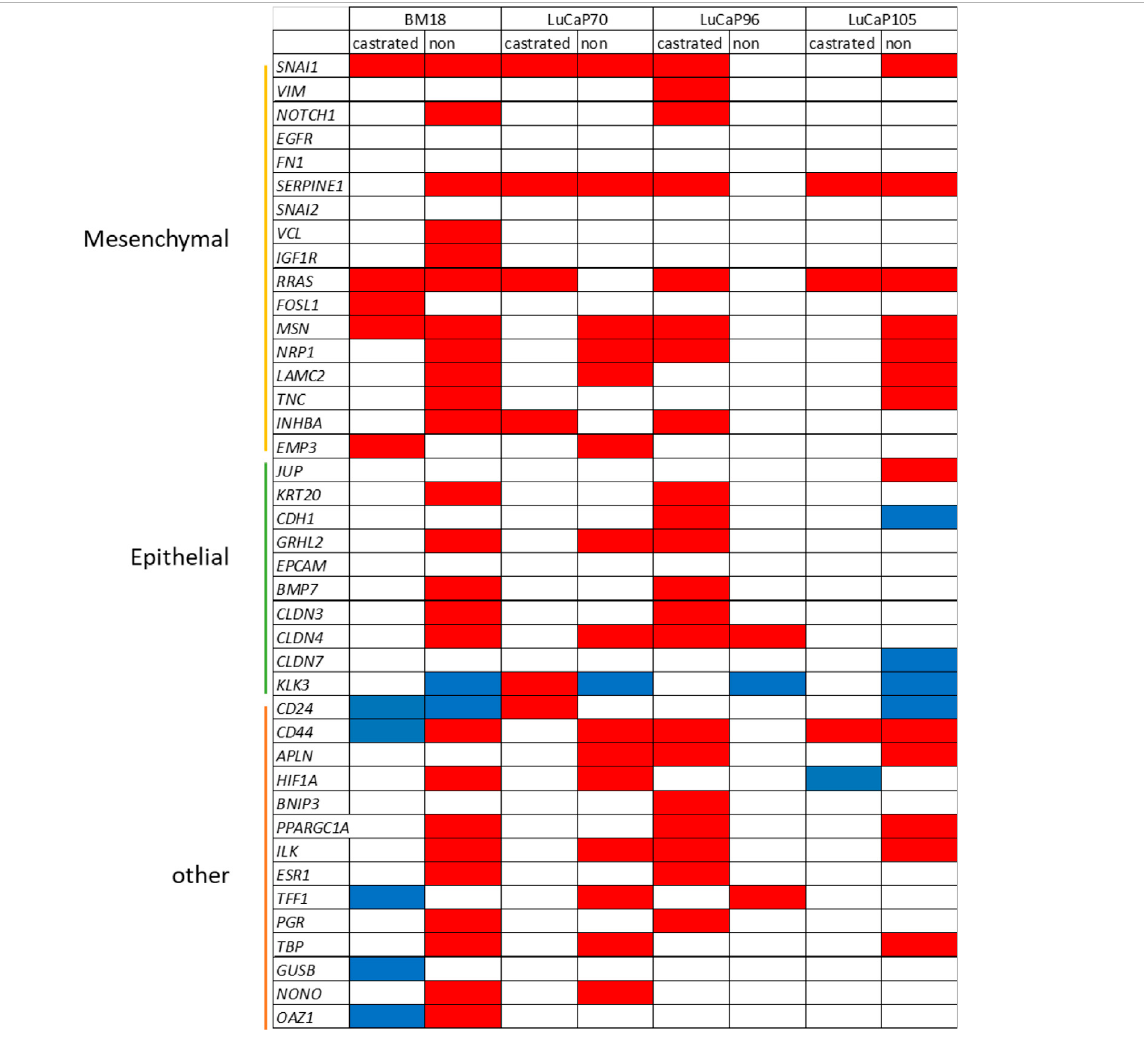
TABLE 4 | Summary of gene expression differences between CTC and primary tumour samples from castrated and non-castrated mice across PDX models.